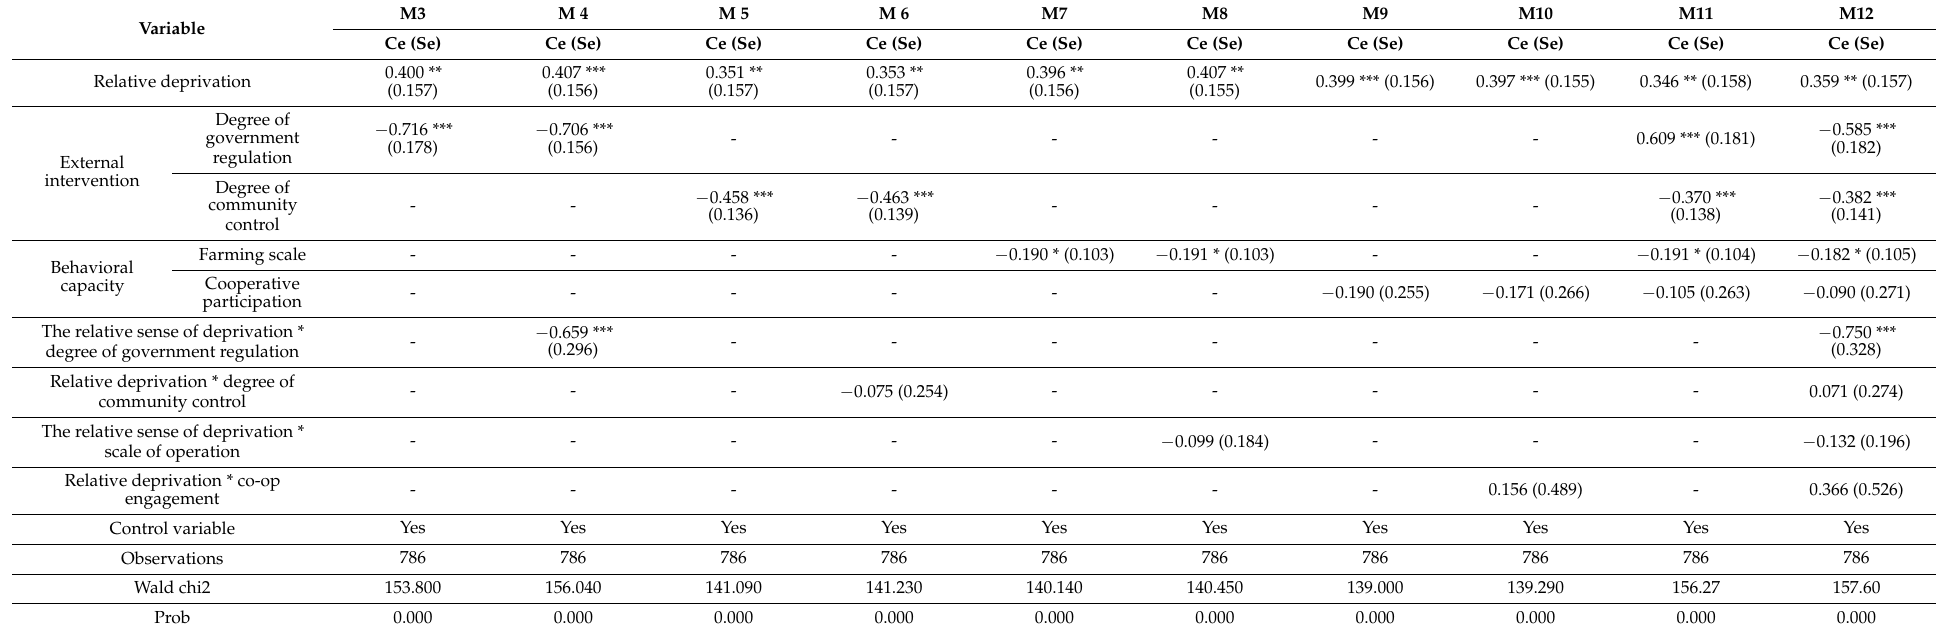
Table 3. Factors of influence on the relative deprivation and pesticide use by tea